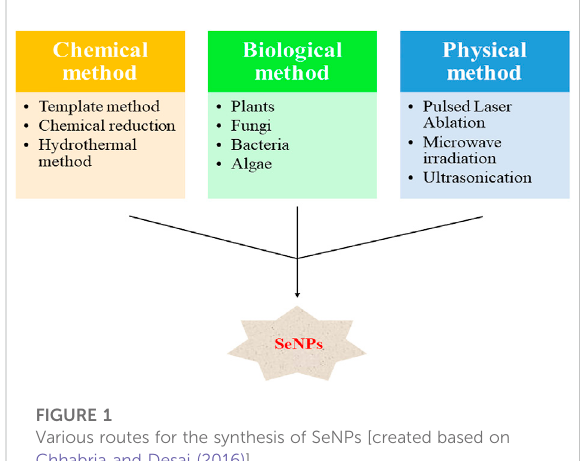
FIGURE 1 Various routes for the synthesis of SeNPs [created based on Chhabria and Desai